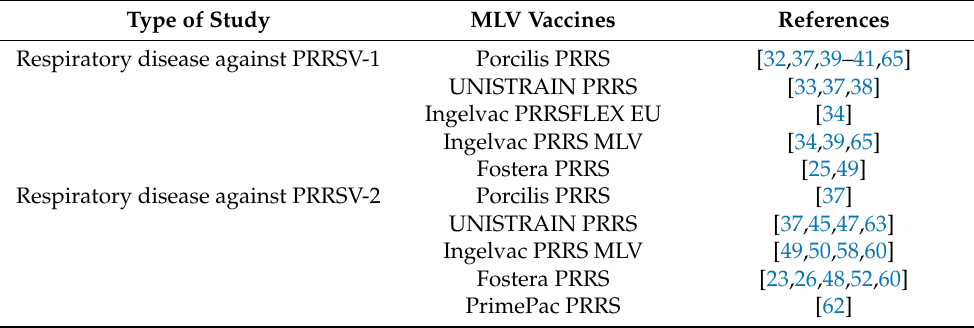
Table 2. Efficacy of PRRS modified-live virus (MLV) vaccines against respiratory disease in growing